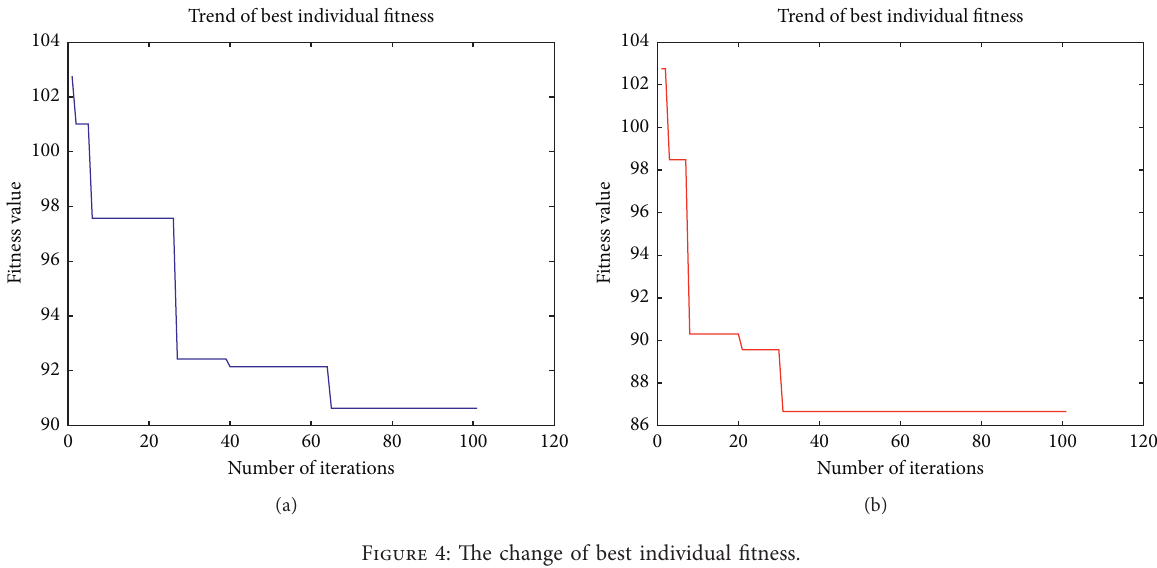
Figure 4: The change of best individual